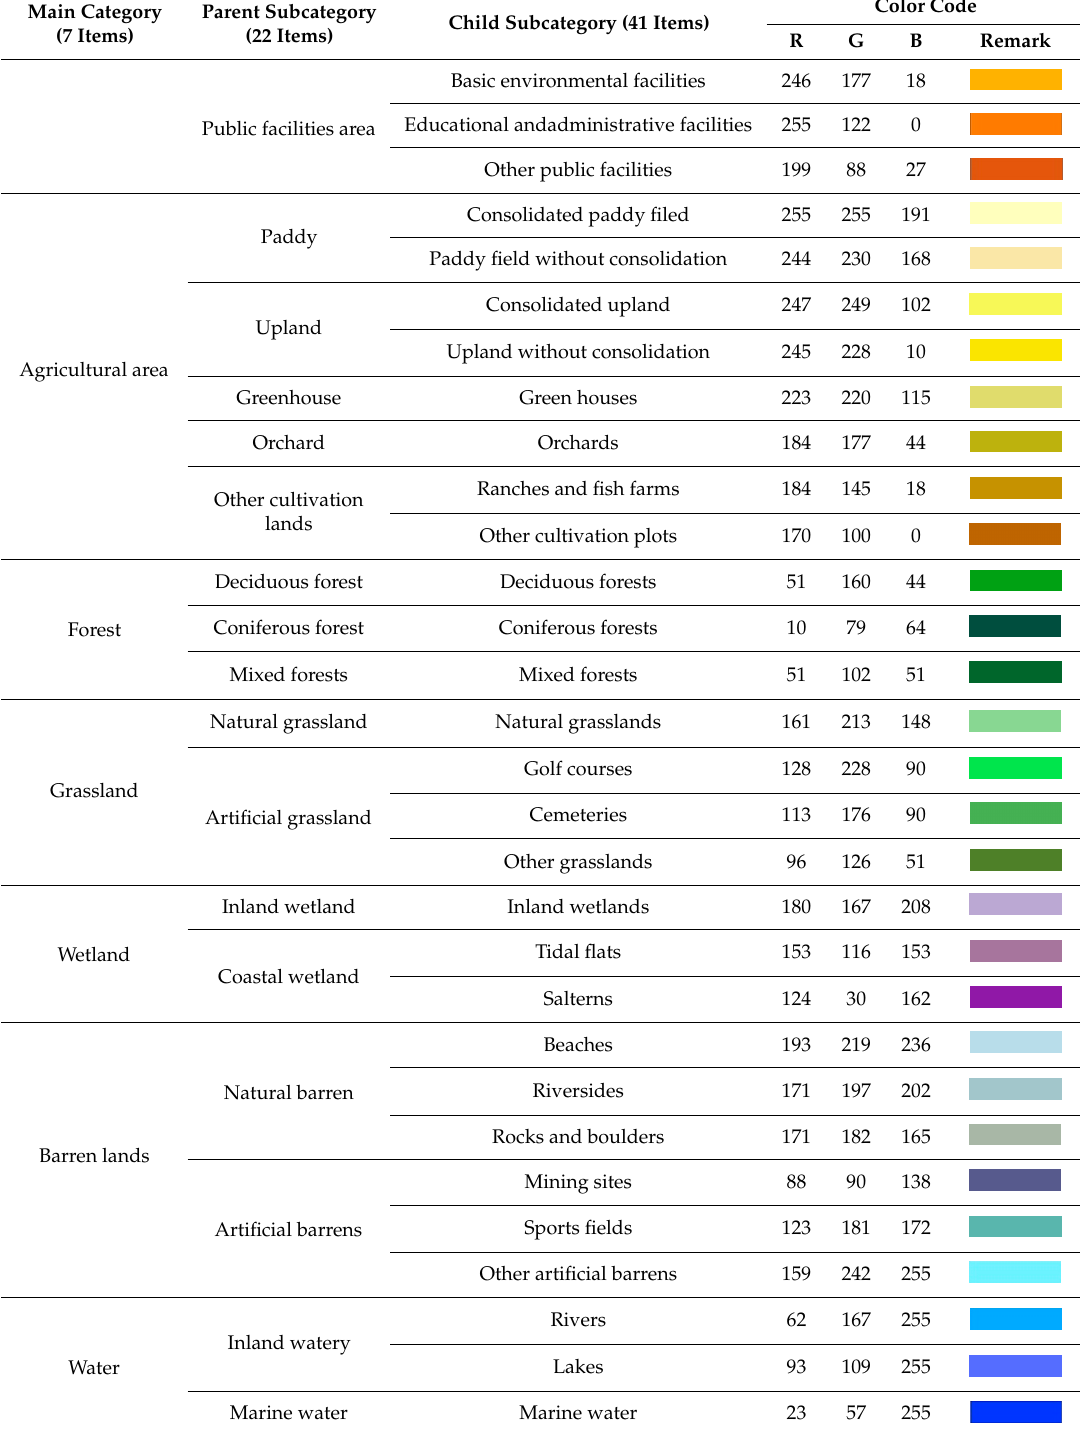
three channels: red (R), green (G), blue (B), of the HRRS image. The land cover classification result is expressed in values that are closest to the learned classification color for each land cover (Table